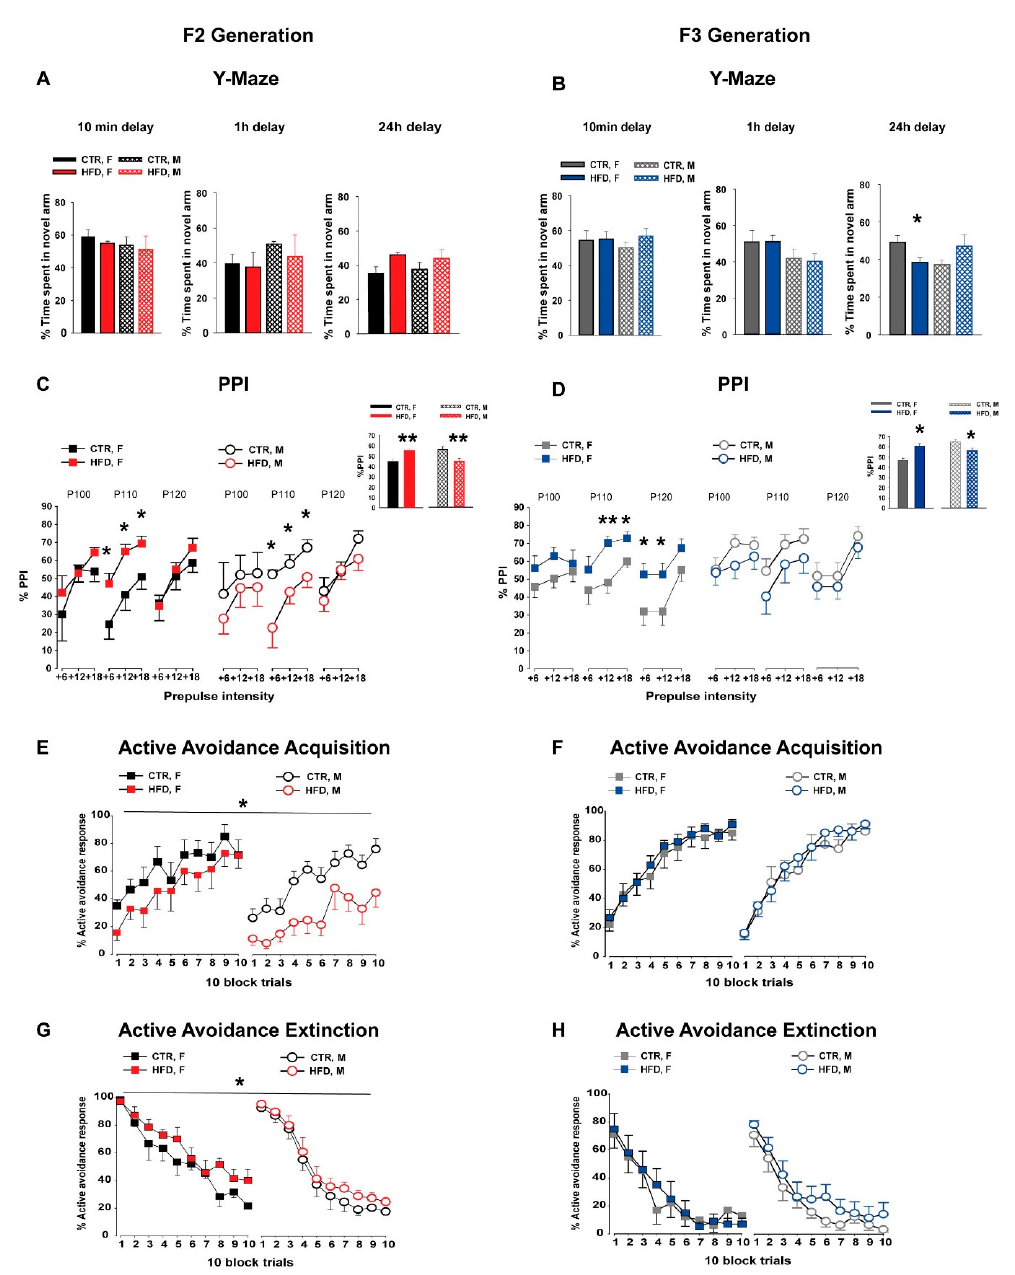
Figure 2. Cognitive assessments in the F2 and F3 generations. ( A , B ) Working memory in the Y-maze. The bar plot depicts the percentage time spent in the novel arm during the 5-min test phase for three different delays. The percentage time spent in the novel arm was assessed by the ratio of time spent